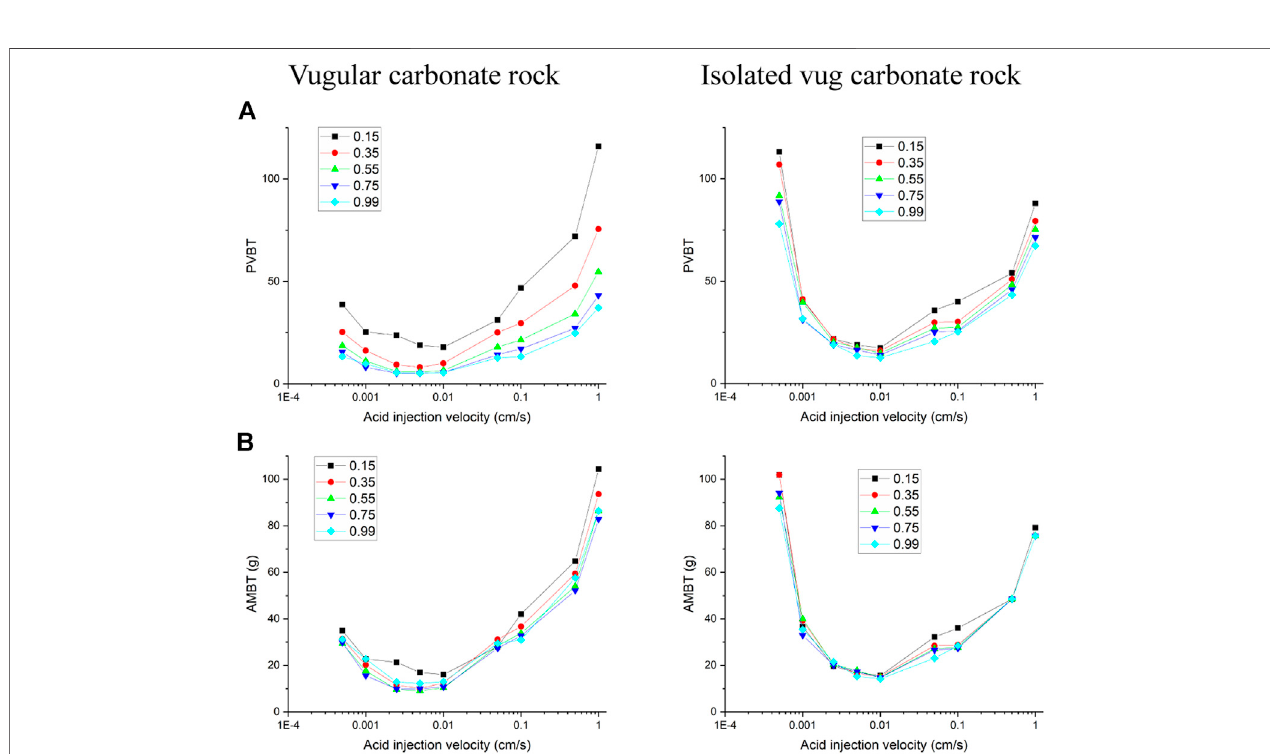
FIGURE 9 | Effect of vug porosity on acidizing curves: (A) pore volume to breakthrough (PVBT) and (B) acid mass to breakthrough (AMBT).